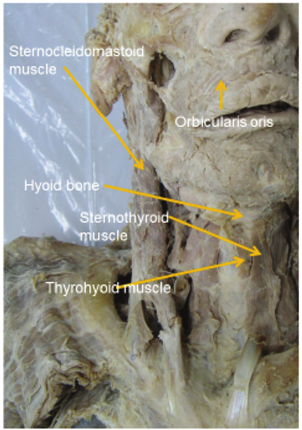
Figure 3: An example of one of the trophy images unlocked after successful completion of one of the online quizzes (wet specimen).